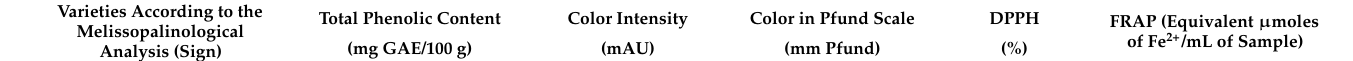
Table 4. The results of research on antioxidant properties—division into varieties according to the results of melissopalinological